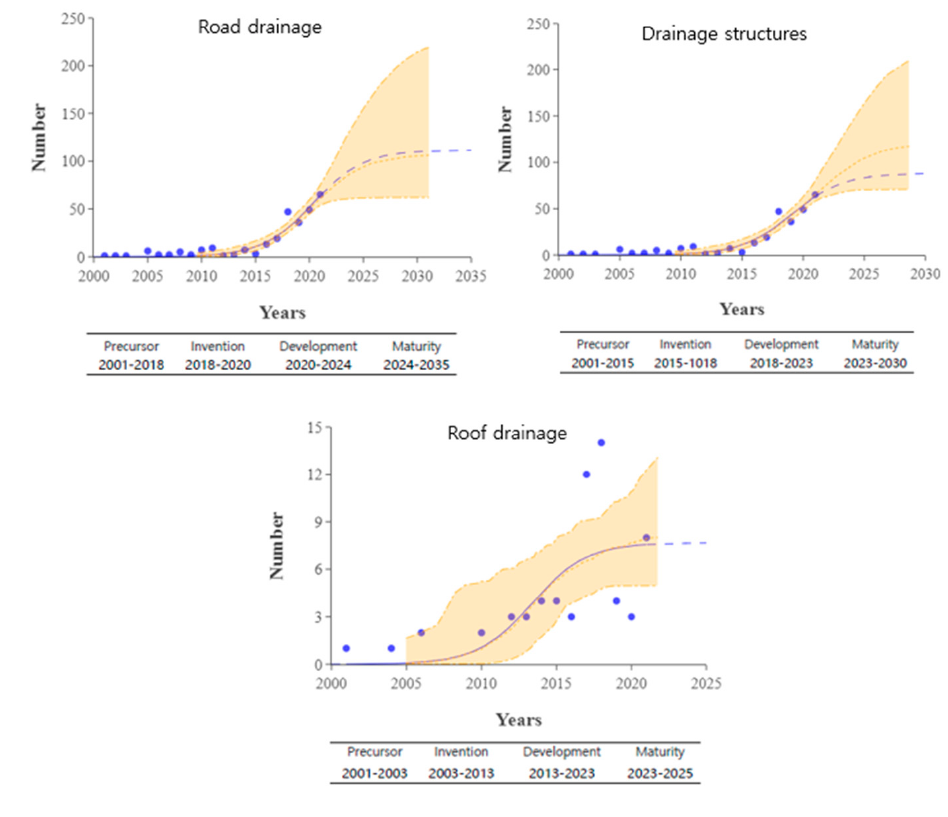
Figure 16. S-curves for drainage in patents.